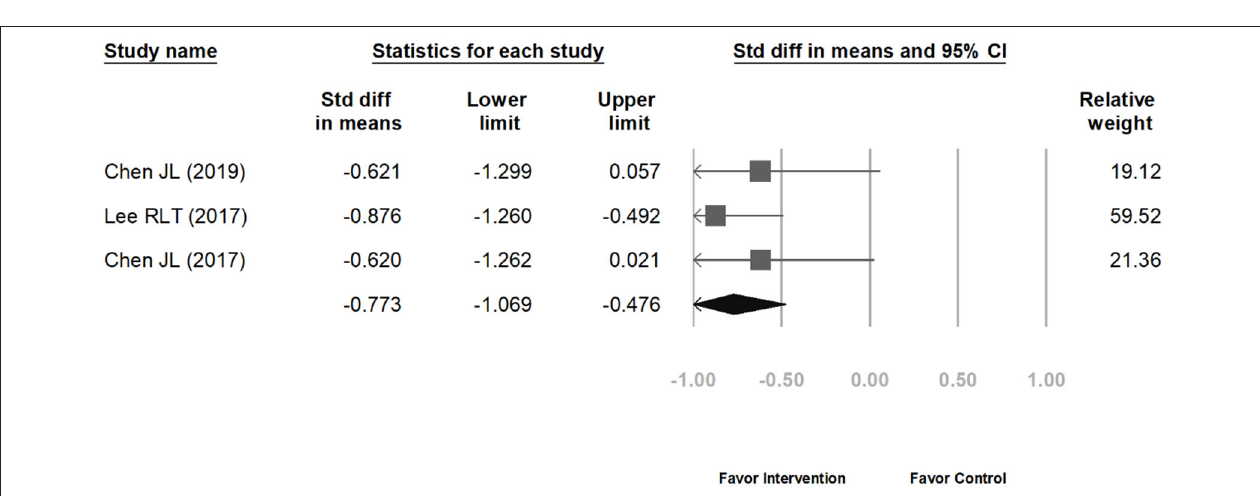
FIGURE 3 | The weight loss effect between the intervention and control groups of the ethnic Chinese